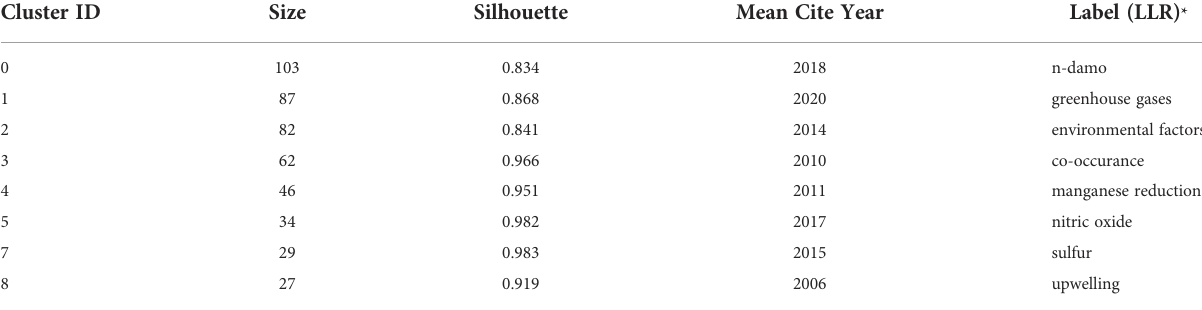
TABLE 2 Major clusters of the co-cited